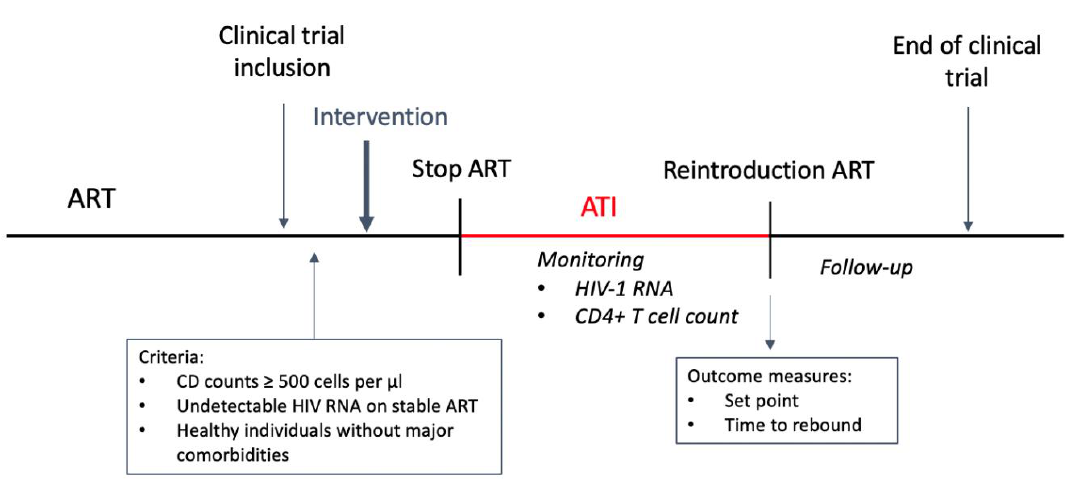
Figure 1. ATI scheme. Intervention can include multiple doses throughout the trial. Immunological response is assessed during